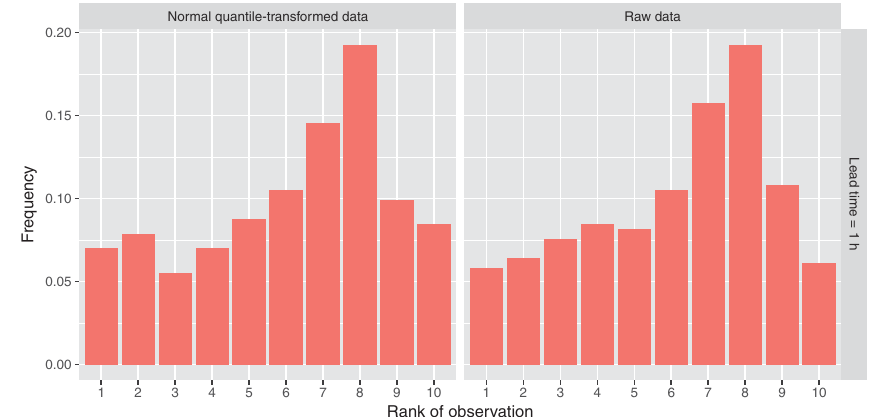
Figure 10. Rank histograms for the WRF ensemble for the Mugroso watershed for the finest domain (resolution of 1.67km) and lead time of 1h.